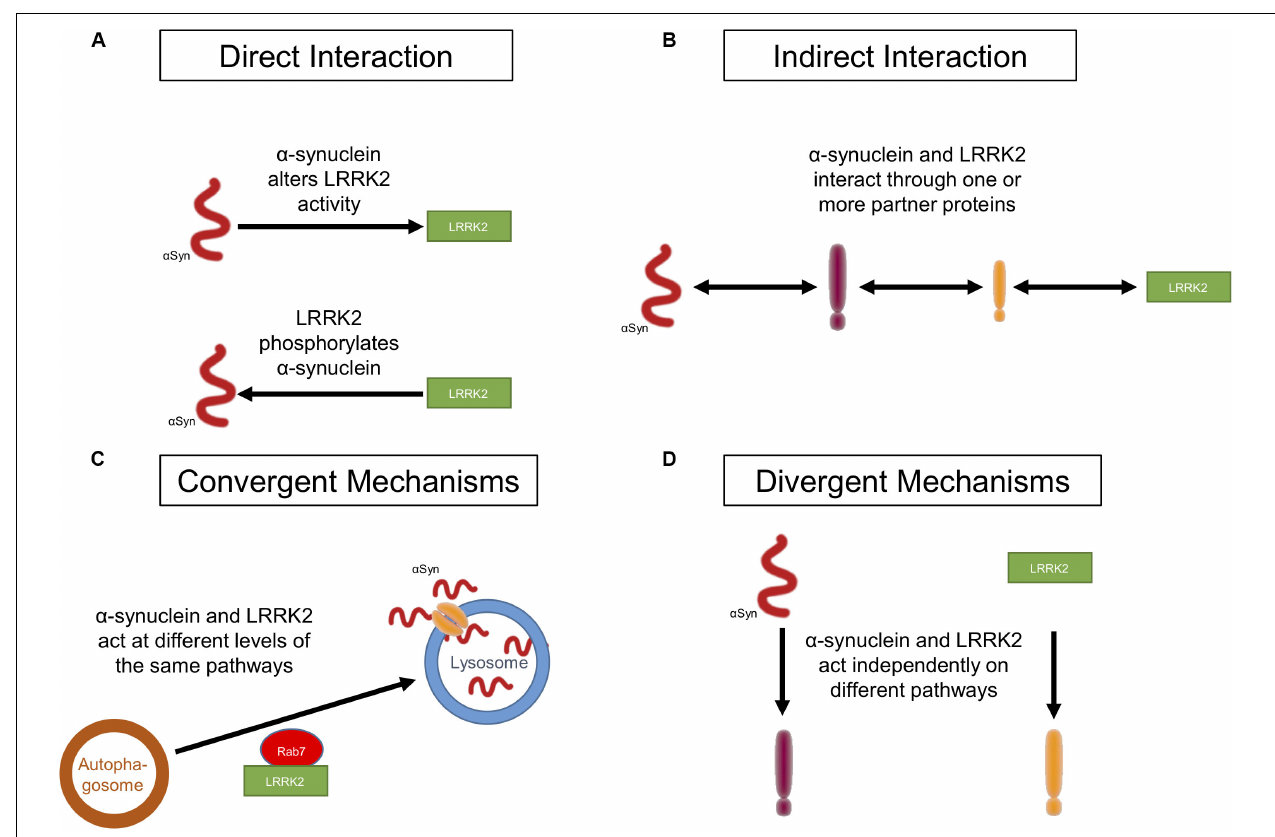
FIGURE 1 | Potential ways in which LRRK2 and α -synuclein act in PD. (A) LRRK2 and α -synuclein affect each other through a direct physical interaction. (B) LRRK2 and α -synuclein affect each other through an indirect physical interaction in which a mediator(s), such as a molecular chaperone(s), links the two proteins. (C) Both LRRK2 and α -synuclein act synergistically on targets within the same molecular pathway without interacting with each other. (D) LRRK2 and α -synuclein do not interact at all and each affect targets in distinct molecular